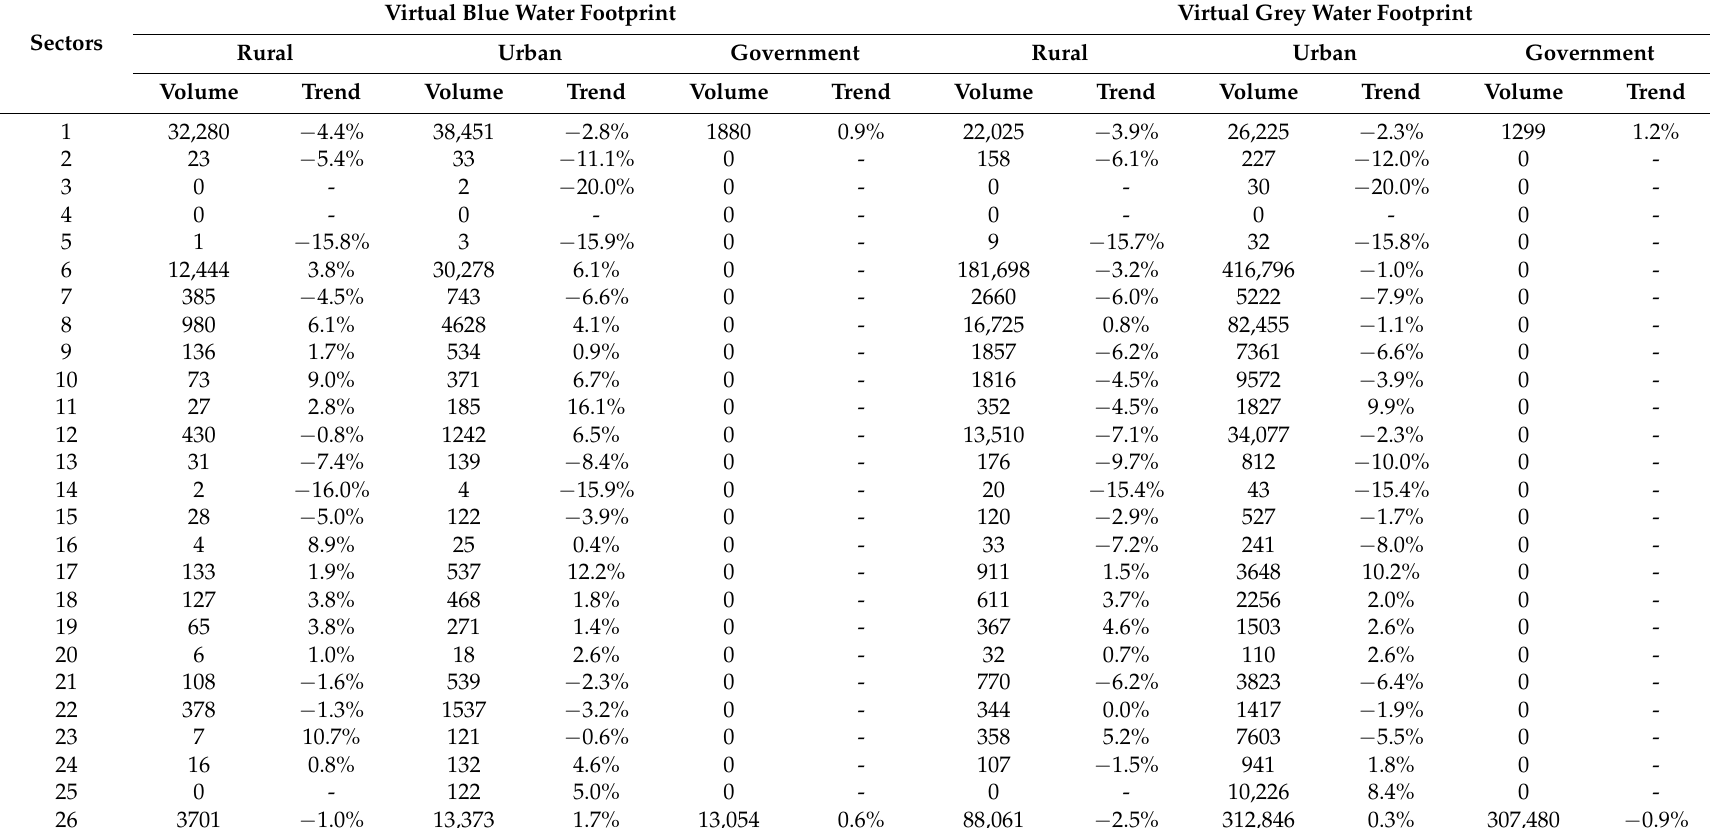
Table 3. Average volumes and change trends of WF blue,virtual and WF grey,virtual caused by rural residents’ consumption, urban residents’ consumption and government consumption from 2002 to 2012. (unit: million m 3